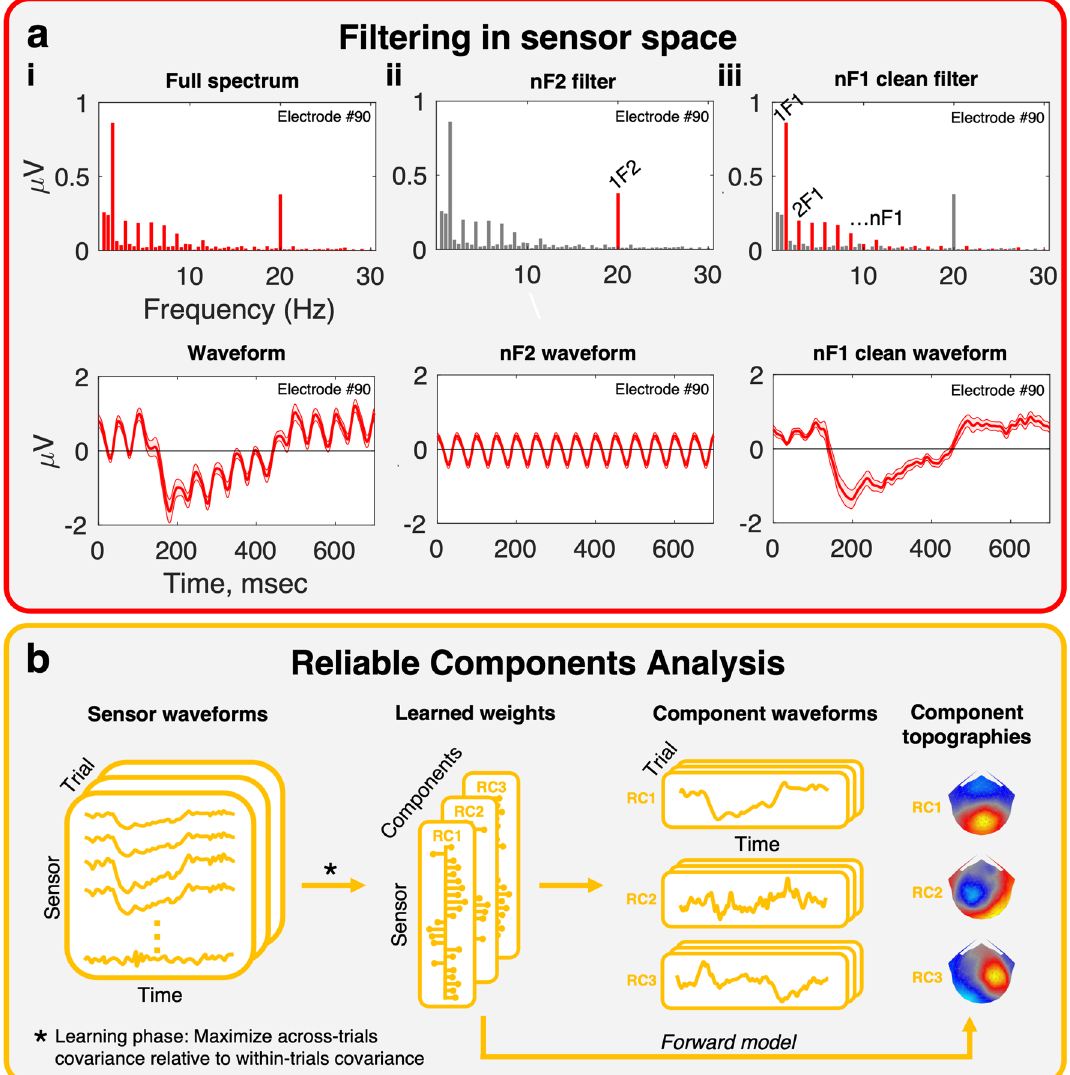
Figure 7. Two key stages in the data processing pipeline. ( a ) Filtering in sensor-space. Fourier pairs (spectra on the top row, and corresponding waveforms on the bottom row) illustrate different filter types. The full spectrum, a ( i ), contains both signal and noise harmonics, dominated by signals at multiples of the fundamental frequencies in the stimulus. This signal can be filtered to highlight different response components. The nF2 filter, a ( ii ), removes all frequencies in the response except those at multiples of 1F2 (in our stimuli, the dot update rate at 20 Hz). The dot update can also be removed, and the disparity response highlighted, using the nF1 clean filter, a ( iii ). Here, multiples of the 1F1 fundamental (in our stimuli, disparity update at 2 Hz) are preserved and all other frequencies are removed. The reconstructed waveform is a “clean” version of the full waveform, with non-disparity and dot update signals removed. ( b ) Dimensionality reduction via Reliable Components Analysis. The nF1 clean data are provided as input to the RCA pipeline, where components are learned that maximise the across-trials covariance relative to the within-trials covariance. Components are vectors of electrode weights where electrodes that respond in a consistent manner across trials are emphasized. These learned weights can be projected through a forward model, revealing underlying neural sources in the form of component topographies. Trial data are projected through the weight vectors to generate mean responses for each component, reducing the dimensionality of the data from 128 sensors to a small number of reliable components. Typically RCA is run on the group level, where input data are individual participant trials but weights are learned across all participants, resulting in group-level topographies and group-level